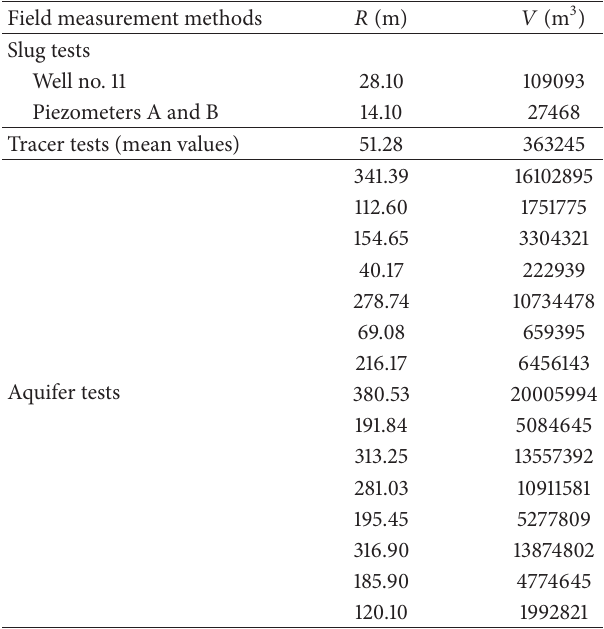
Table 4: Values of the scale parameters 𝑅 and 𝑉 for each field measurement method considered.